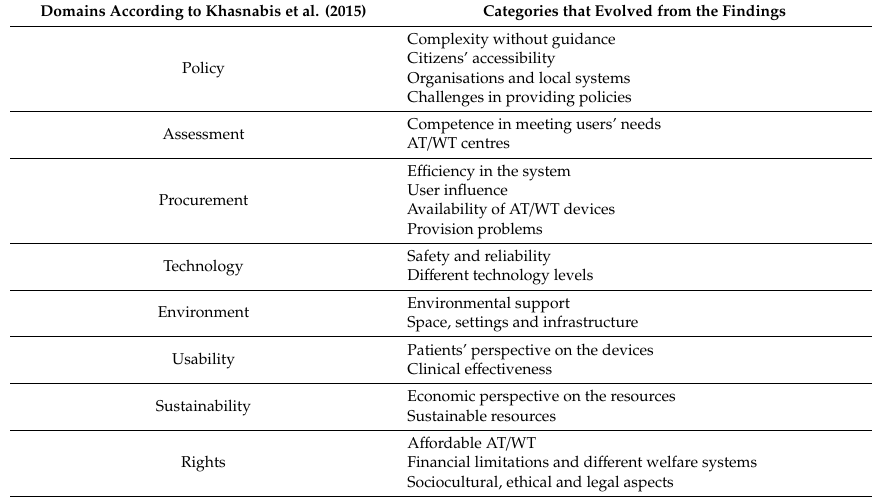
Table 2. The domains and the categories that evolved from the findings in the literature review. Domains According to Khasnabis et al.